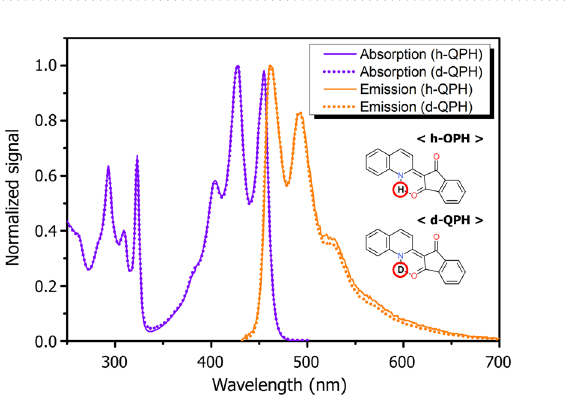
Figure 1. Possible tautomers of QPH.